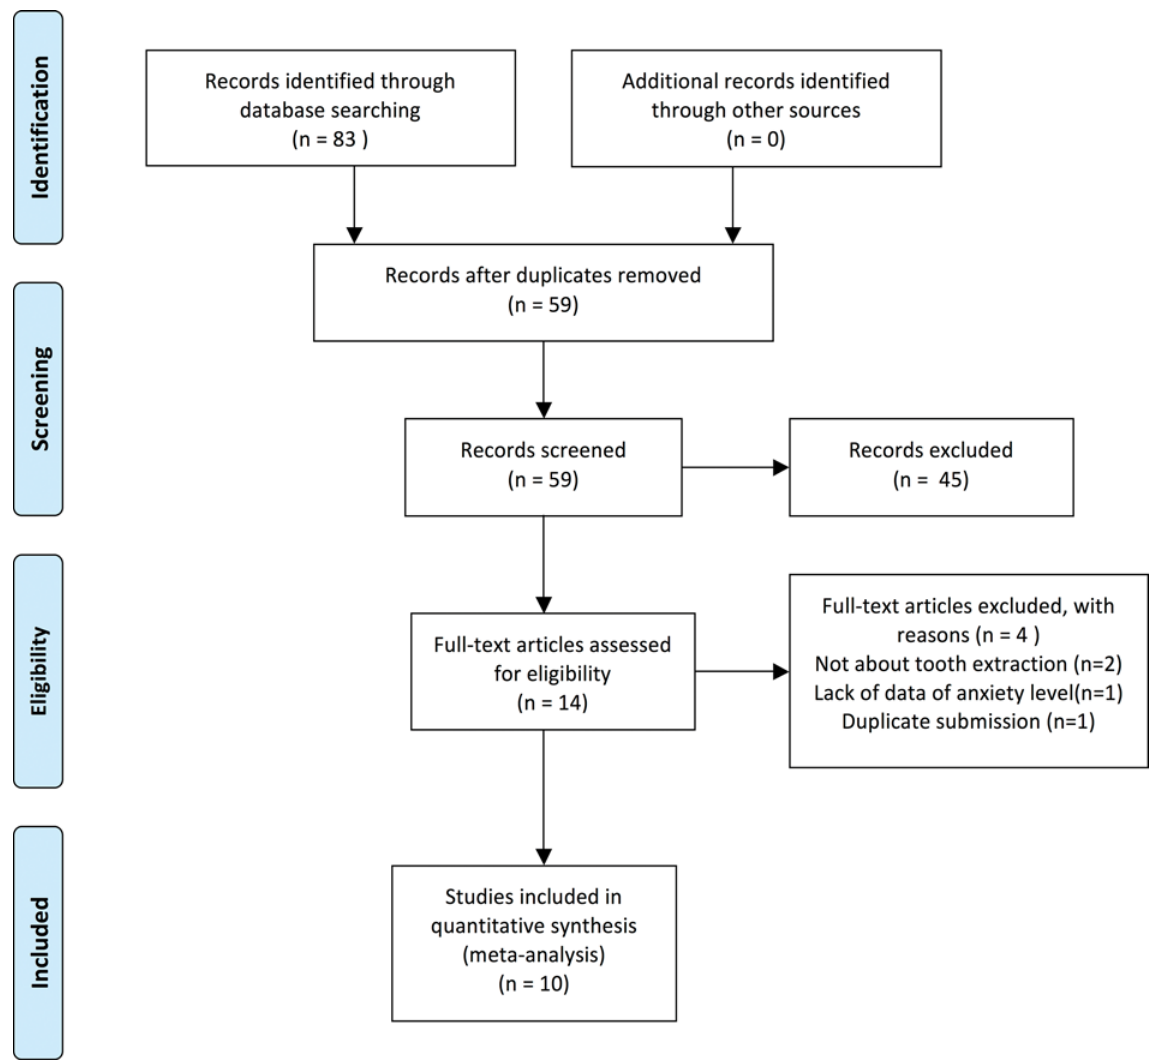
Fig 1. Flow Diagram for Study Search and Inclusion.